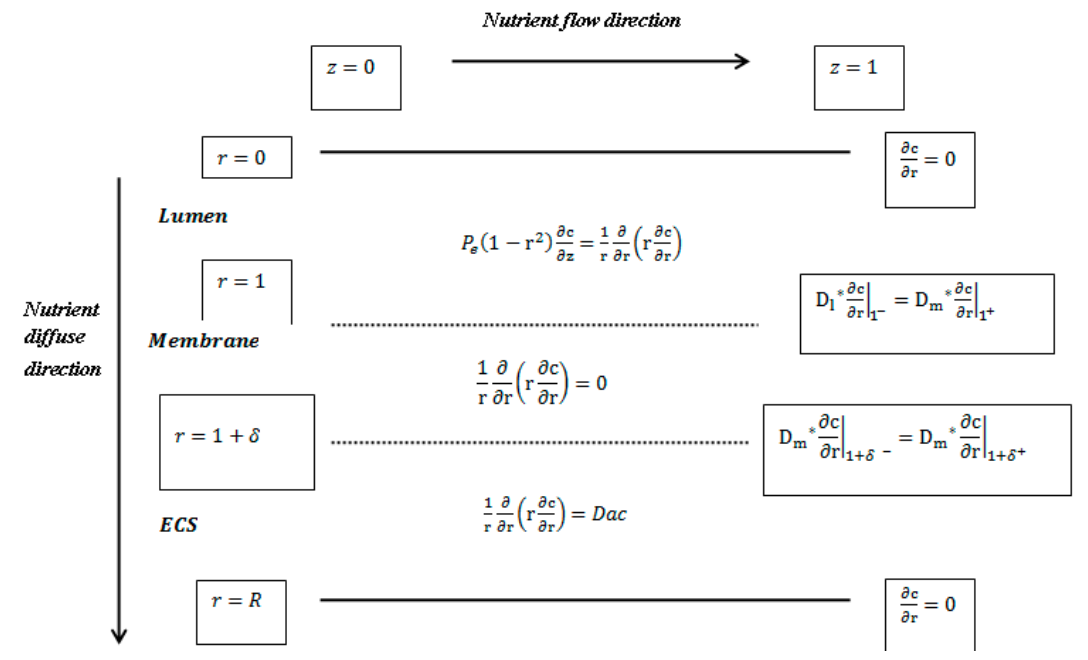
Figure 4. Dimensionless governing equations and boundary conditions in lumen, membrane, and extracapillary space (ECS) regions (adopted from [29]).